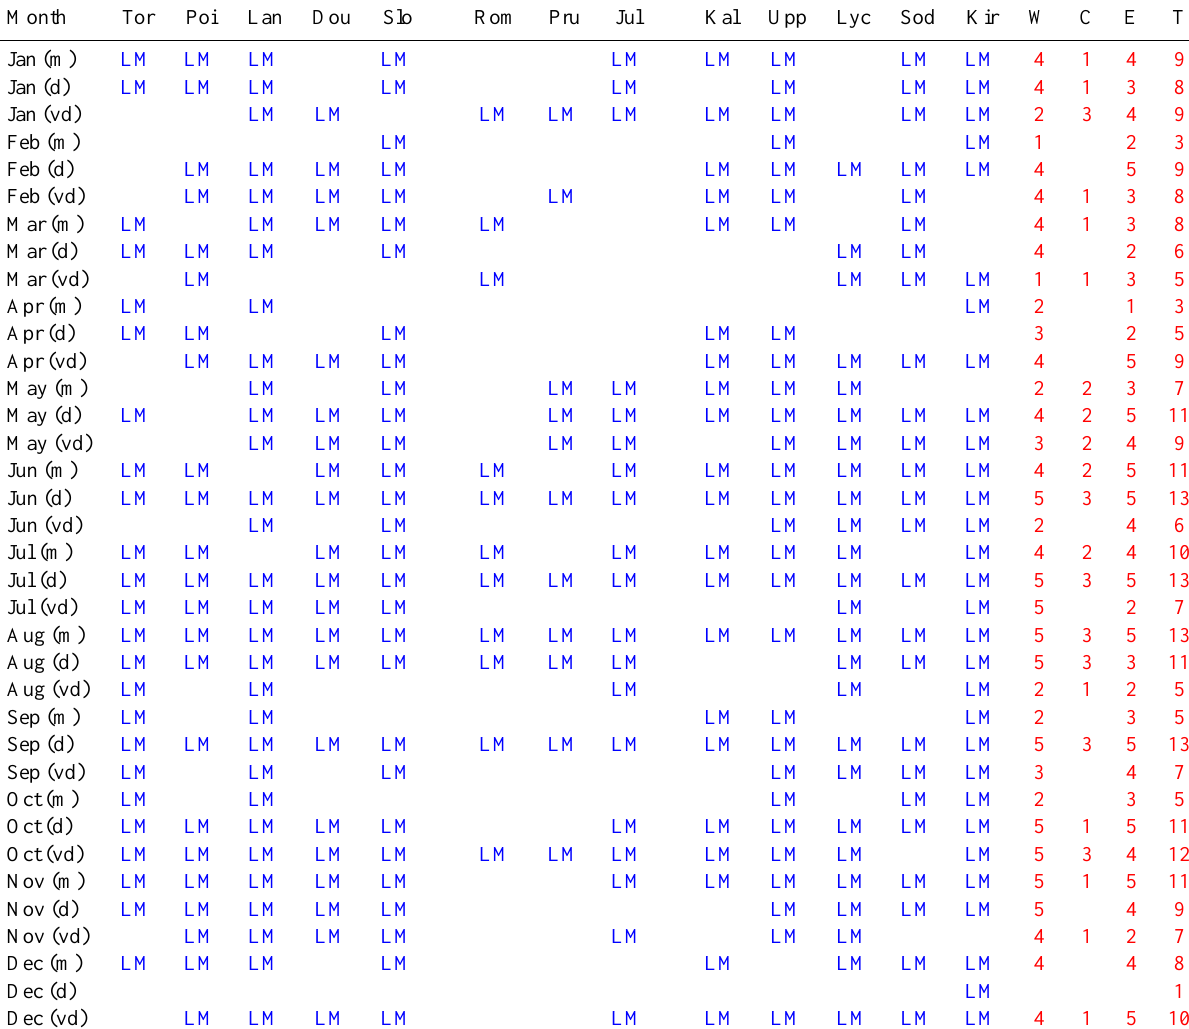
Table 4. The cases in which it is possible to consider the different local models simultaneously operative (indicated with LM) for forecasting fo F2 over the European area are shown for each month under moderate (m), disturbed (d), and very disturbed (vd) geomagnetic conditions. The number of IFELM sites operating simultaneously in the western, central and eastern part of the European area under consideration, are shown in red in the columns (W), (C), and (E) respectively. The empty cells indicate cases that were discarded because the performance of IFELM was worse than that of STORM fo F2 MED , IRI . The values in the last column indicate the total number of IFELM sites operating at the same